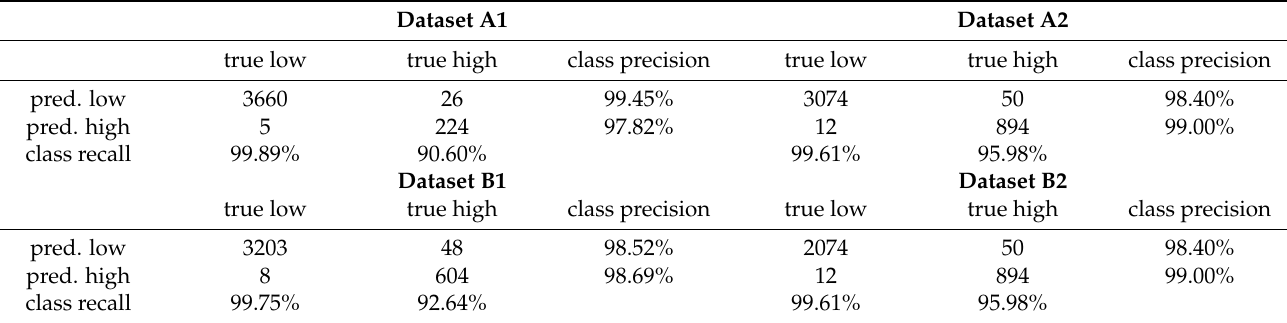
Table 6. Confusion matrix with the classification generated using SVM. This table shows the classification obtained with labels “low” and “high”, using datasets A1, A2, B1, and B2. Table 6 also shows the accuracy, recall, and class-precision values for both matrices.